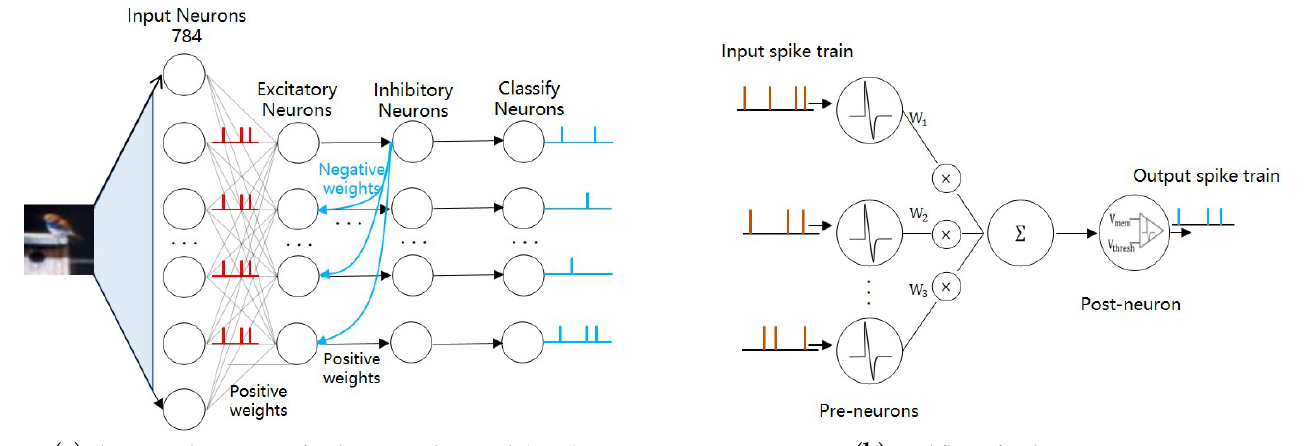
Figure 1. Spike neuron network. ( a ) represents the structure of the spiking neural network. The image is input into the network and propagated forward in the form of spike sequences. Then, a set of spike sequences for classification is obtained through excitatory neurons or inhibitory neurons; ( b ) represents the network in the structure of neurons in a certain layer. The spike sequence enters the neurons and integrates and fires the spikes, which are transmitted to the next layer of neurons as